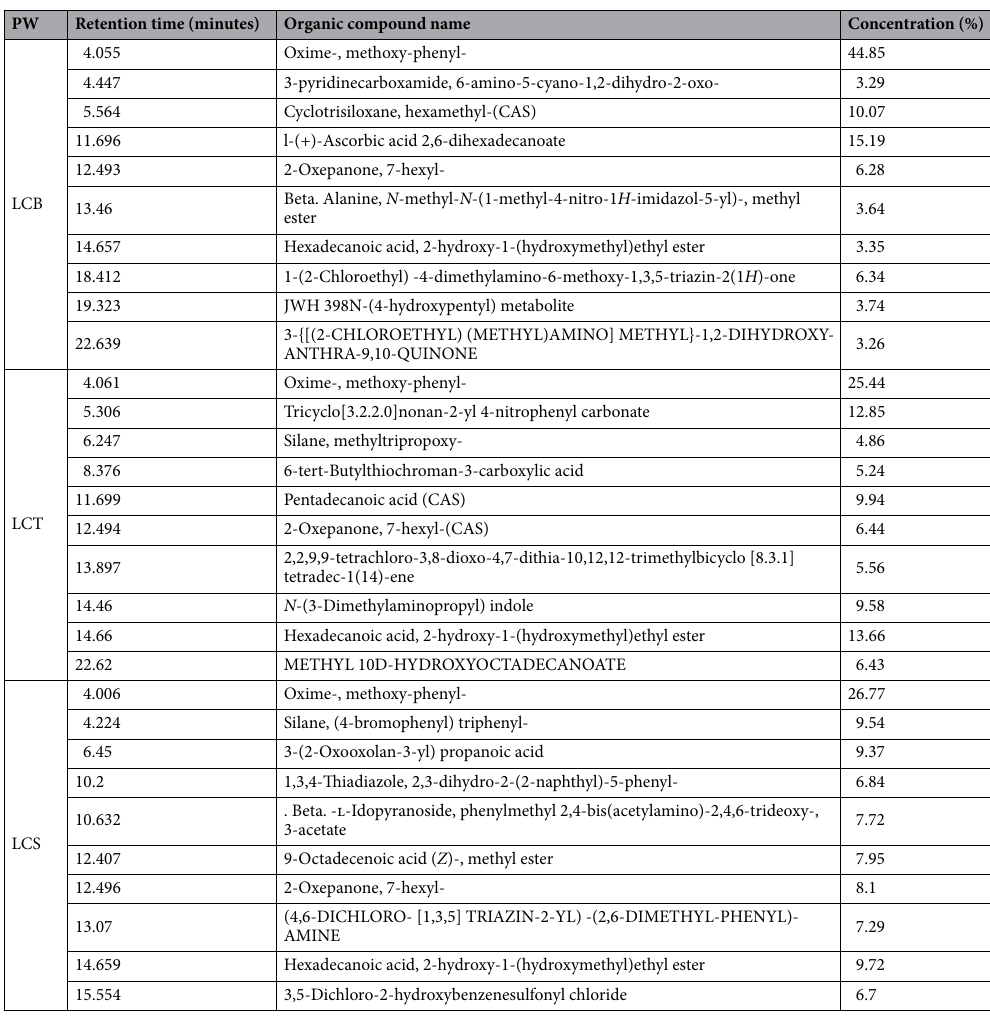
Table 11. Identification and concentration of organic compounds in PW. PW process water from HTC and Co-HTC process, LCT PW from coal tailing’s HTC, LCS PW from coal slurry’s HTC, LB PW from Co-HTC of coal and sewage sludge.